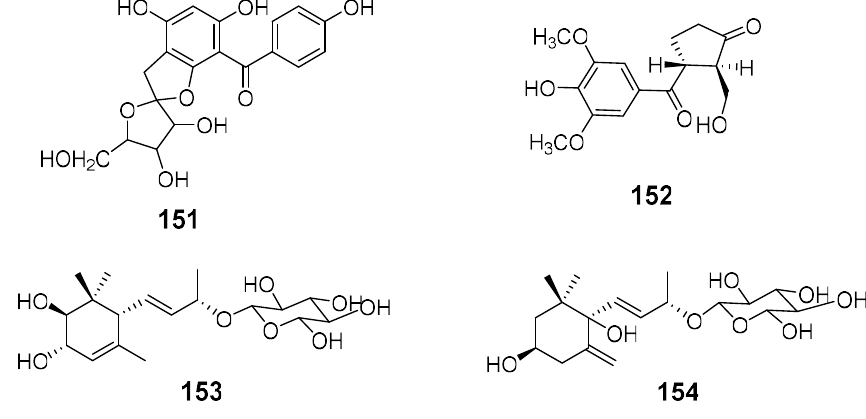
Figure 11. Structures of compounds from agarwood.